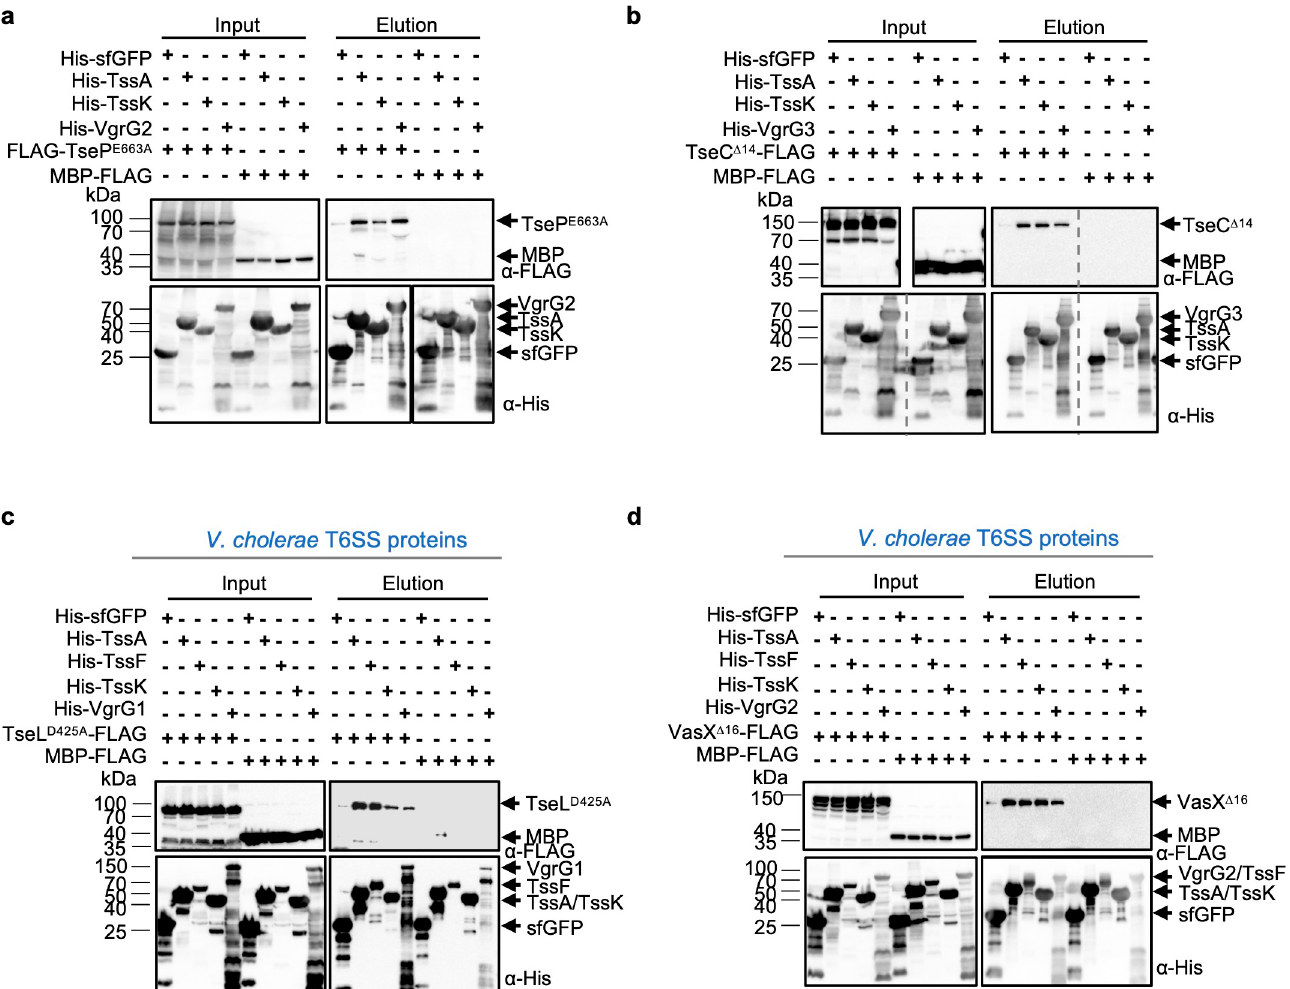
Fig 5. Interaction of effectors with baseplate proteins. A , Pull-down analysis of structural proteins and TssA with the catalytically inactive effector TseP E663A . B , Pull-down analysis of structural proteins and TssA with TseC Δ 14 . C , Pull-down analysis of V . cholerae structural proteins and TssA with the catalytically inactive effector TseL D425A . D , Pull-down analysis of V . cholerae structural proteins and TssA with the colicin-inactive effector VasX Δ 16 . For all pull-down assays, effectors carry a C-terminal or an N-terminal FLAG tag as indicated and bait proteins are fused with an N-terminal 6His tag. His-sfGFP and MBP-FLAG serve as a negative control for nonspecific interaction. Expression of all proteins was induced in E . coli individually, and cell lysates were mixed in pairs. Samples were detected by Western blotting analysis using the anti-FLAG and anti-His antibodies, respectively. All pull-down experiments were performed at least twice and a representative result is